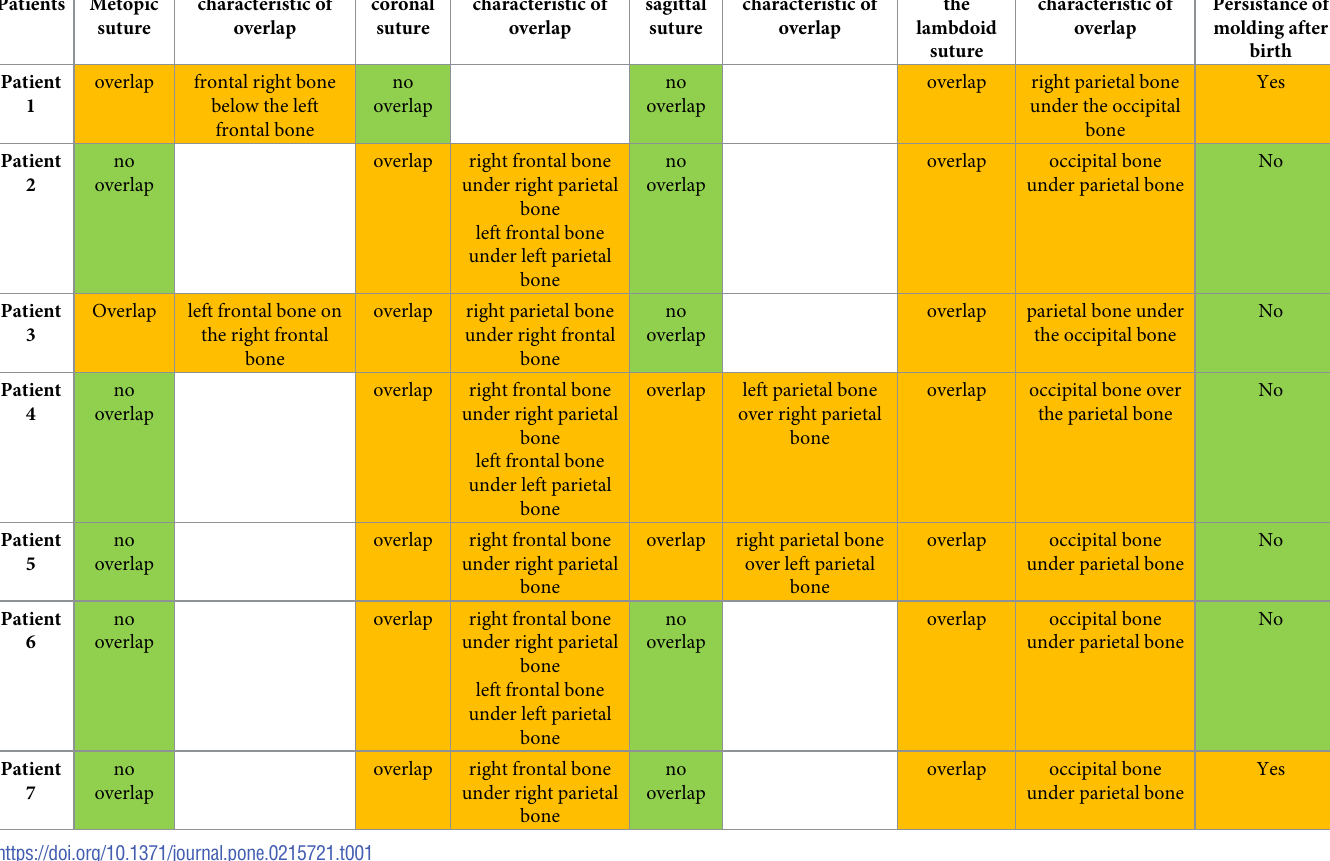
Table 1. Fetal cranial suture overlap observed on MRI performed during the second stage of labor. Patients Metopic